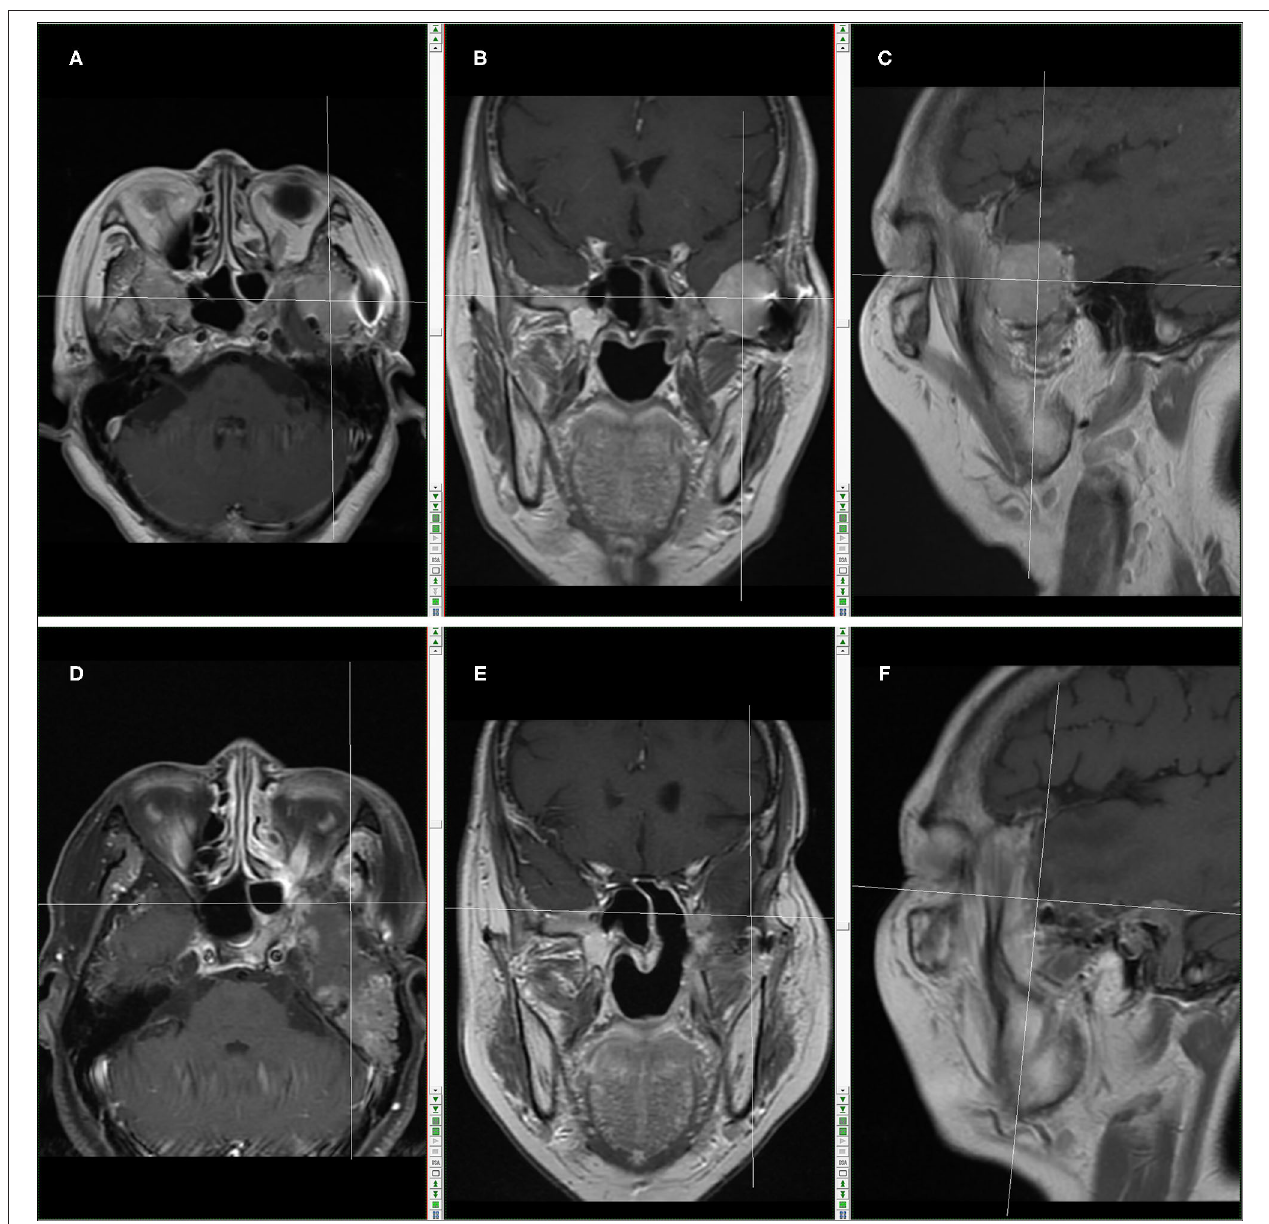
FIGURE 2 | Skull base MRI in May, 2018 (Before the operation combined with carbon-ion radiotherapy): (A) MR images in transection. (B) MR images in coronal plane; (C) MR images in sagittal plane. The cross location denotes the recurring tumor. Skull base MRI in March, 2019 (After the operation combined with carbon-ion radiotherapy): (D) MR images in transection; (E) MR images in coronal plane; (F) MR images in sagittal plane. The cross location denotes no recurrent tumor.